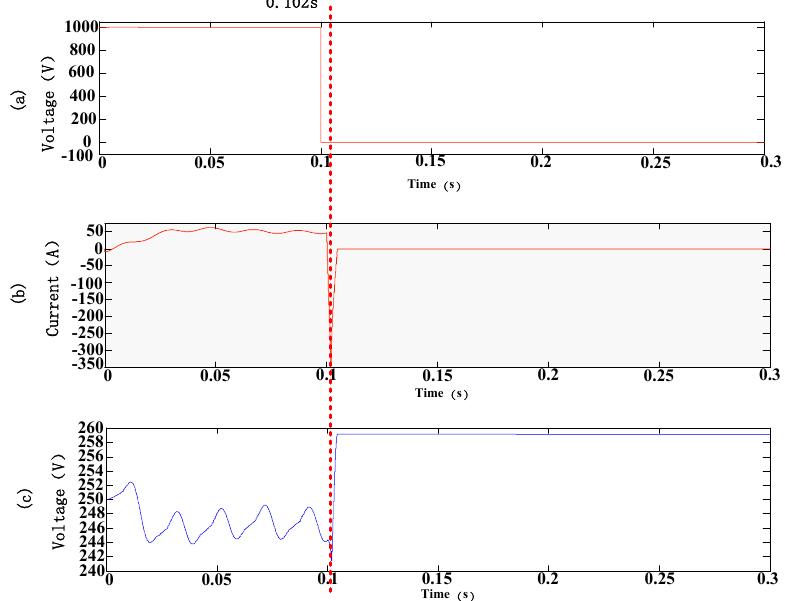
Figure 14. Simulation results of the hybrid nine-arm high-voltage inverter when a DC-side fault occurs 0.1s. ( a ) DC side voltage U dc ; ( b ) DC side current I dc ; ( c ) Capacitor voltage U c .